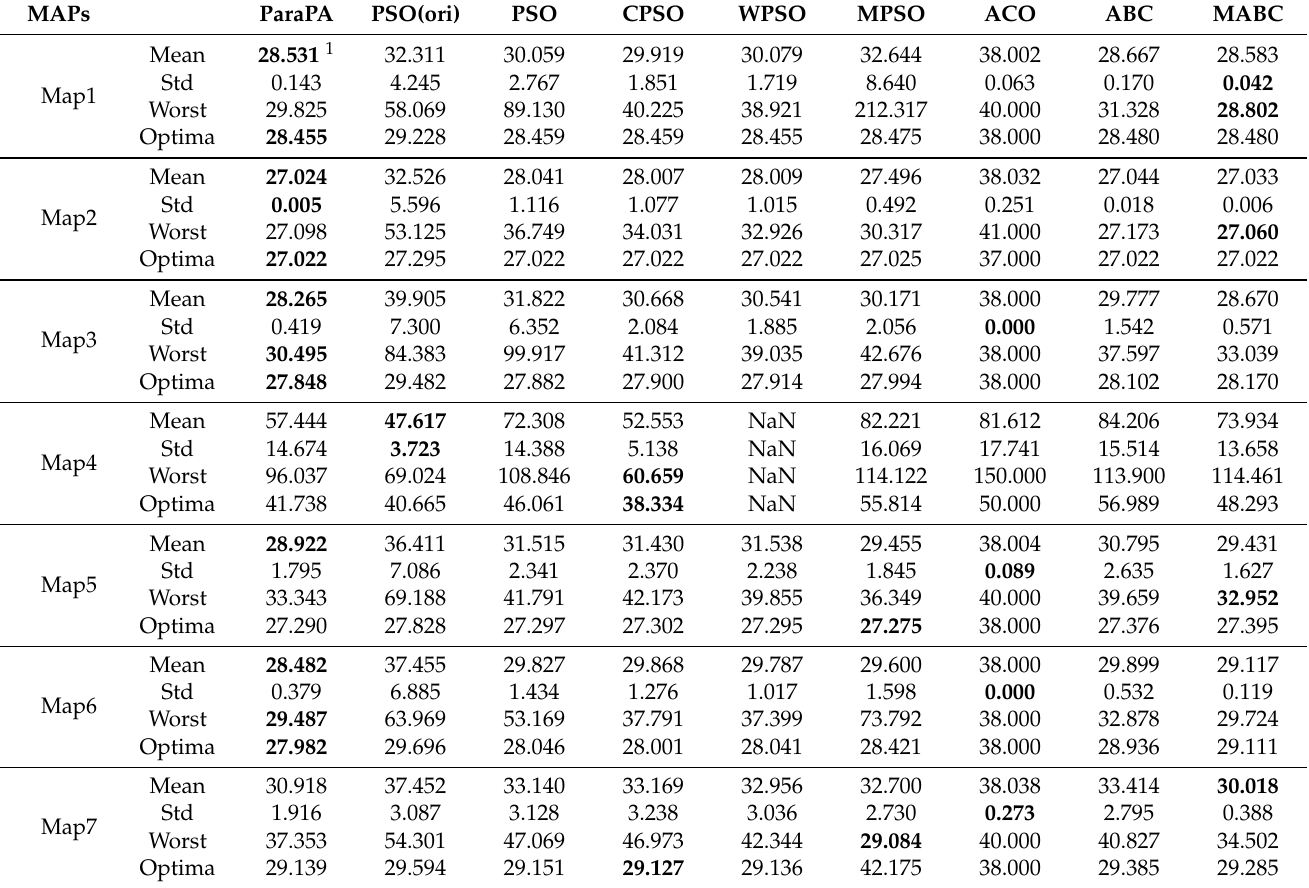
Table 1. Convergence performance comparison for scenario 1 on 20 ∗ 20 maps.